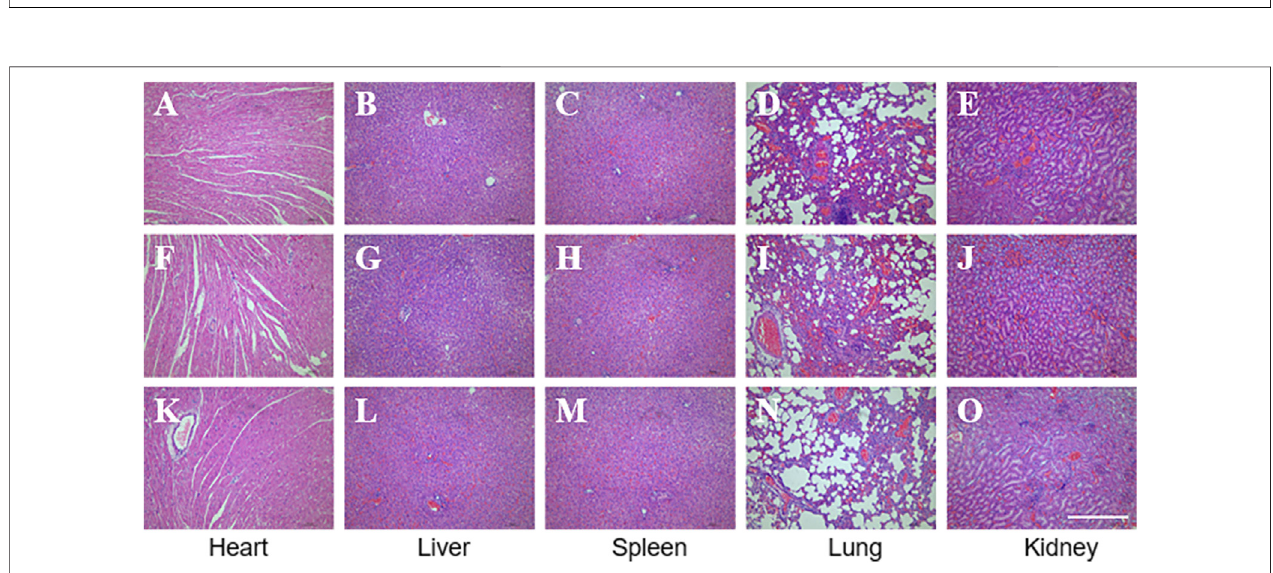
FIGURE5| BiosafetyevaluationofMXene-basednanoscaffolds invivo .HEstainingofthemajorfunctioningorgansofMxene-PCLgroup (A – E) ,PCLgroup (F – J) , and autologous nerve graft group (K – O) . The scale bar is 400 μ m.